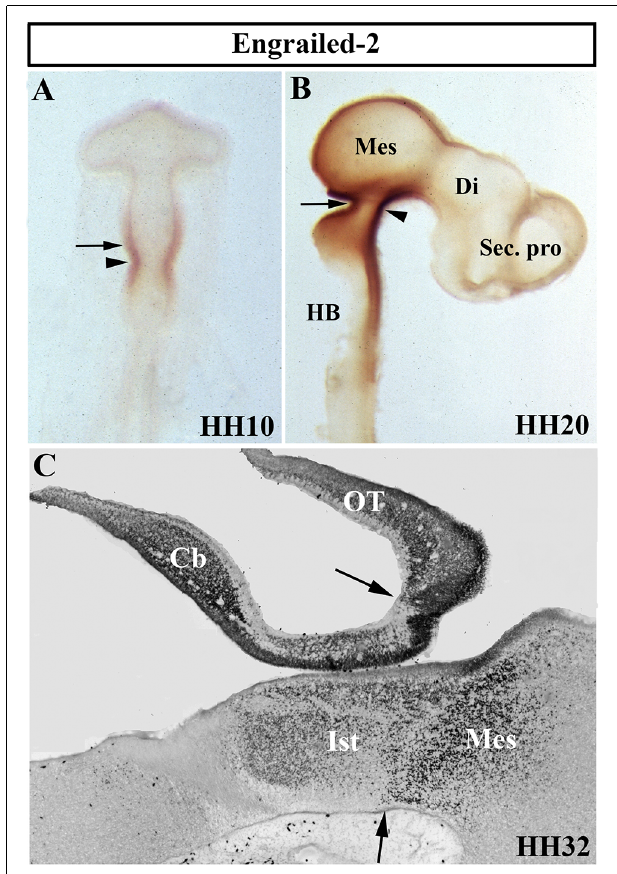
FIGURE 4 | Distribution of Engrailed-2 (En2) at stages HH10 (A) , HH20 (B) , and HH32 (C) using immunoreaction with mAb 4D9 antibody in whole mount embryos (A,B) and in a sagittal section (C) . The arrowheads in (A) and (B) point to the mes/met constriction. En2 staining is observed on both sides of the MH boundary (arrows in A–C ), in a territory which includes the prospective territories of the cerebellum (Cb), isthmus (Ist), and mesencephalon (Mes), the latter developing in part the optic tectum (OT). Di, diencephalon; HB, hindbrain; Sec. pro (secondary prosencephalon). From Hidalgo-Sánchez et al.